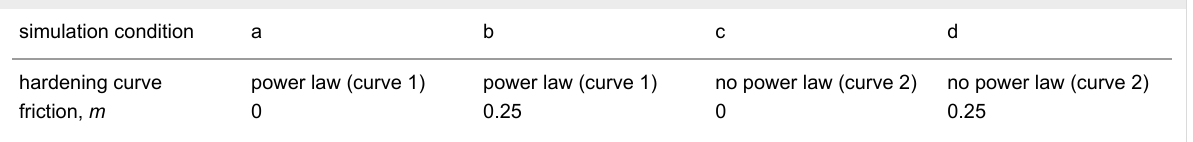
Table 1: Conditions of the numerical